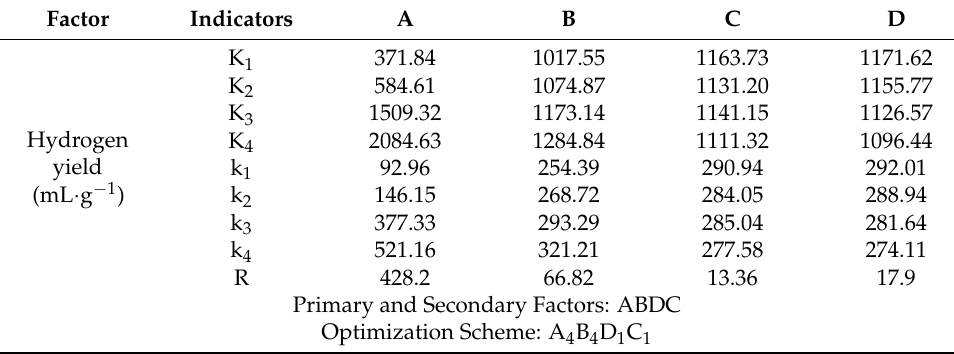
Table 4. Analysis of in situ hydrogen production